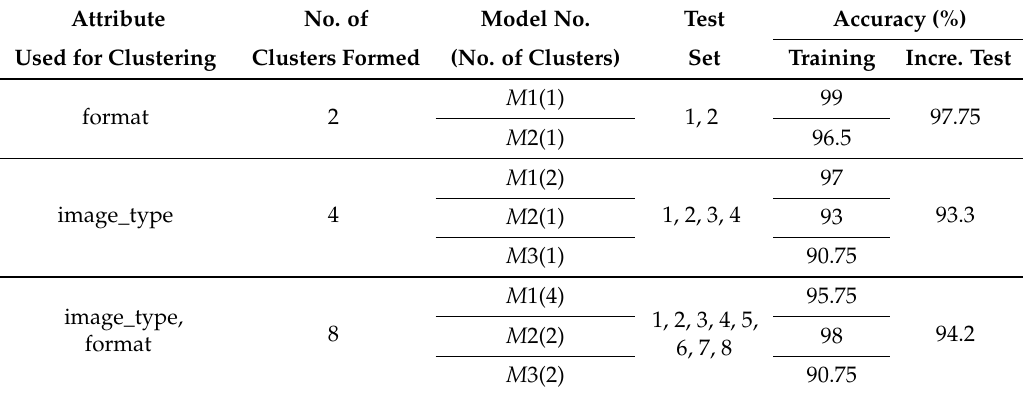
Table 5. Performance Accuracy of